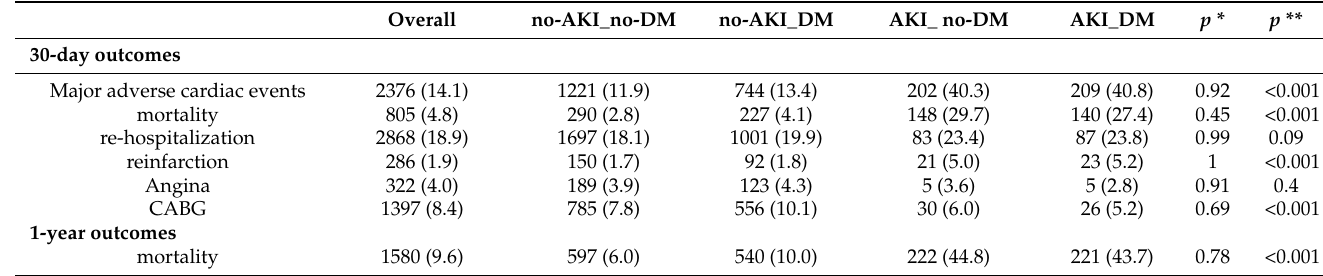
Table 3. Patient outcomes by DM status and AKI.